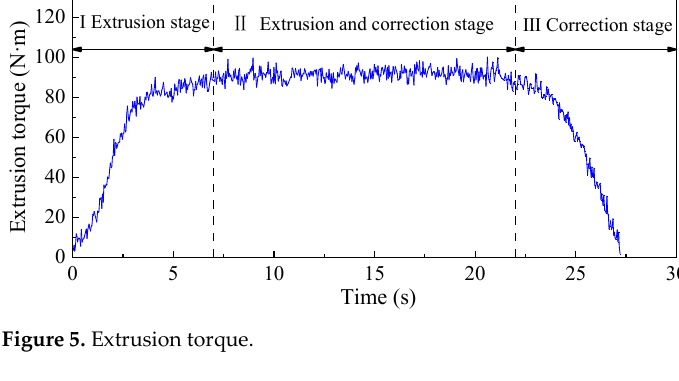
Figure 5. Extrusion torque.